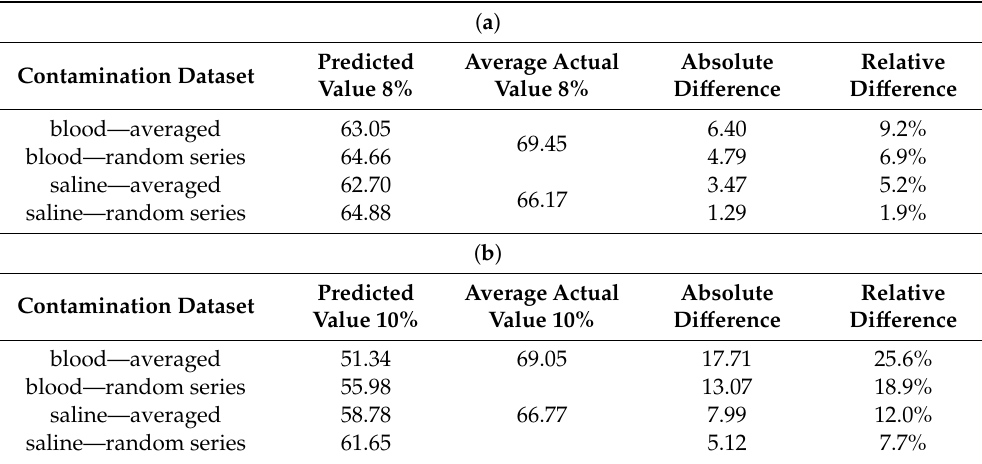
Table 7. Compressive strength prediction accuracy for DLN taught in the range of 0–6%: ( a ) 8% contamination and ( b ) 10% contamination.